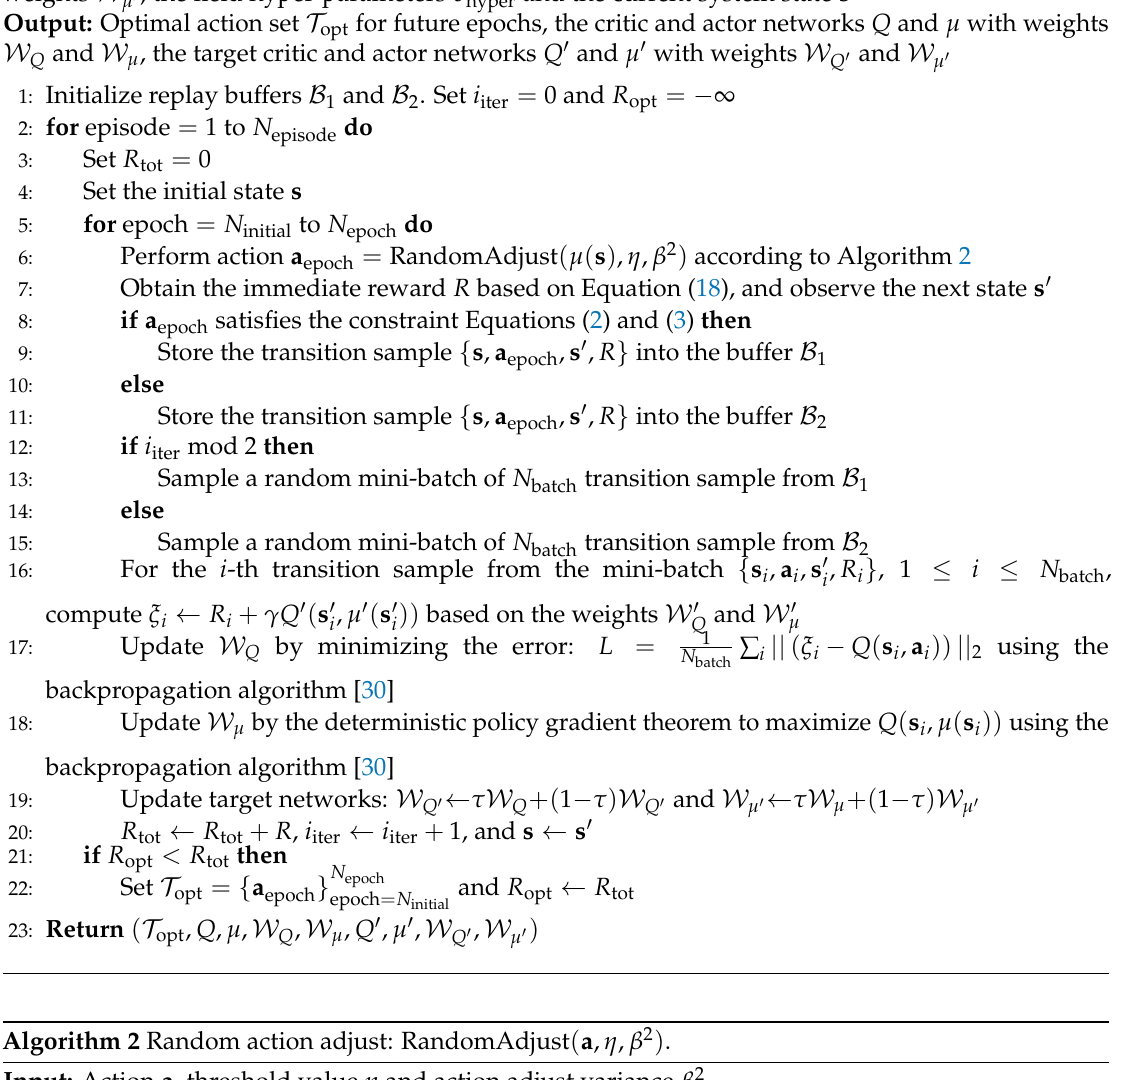
Algorithm 1 Modified deterministic policy gradient (MDPPG) algorithm: